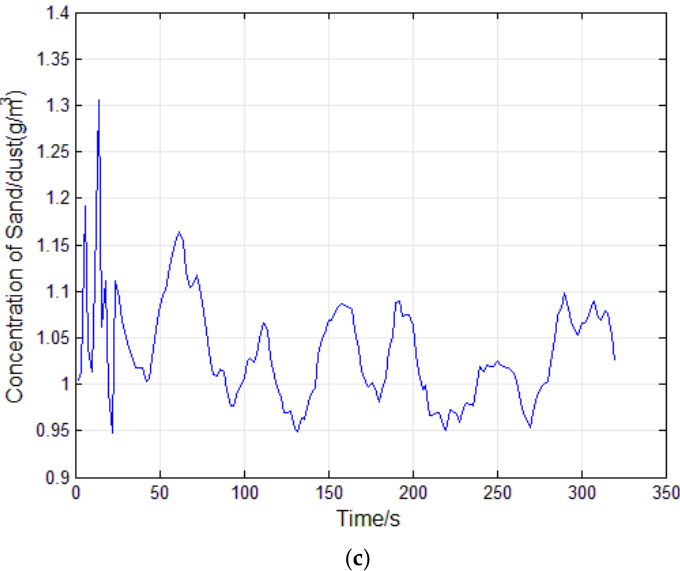
Figure 13. ( a ) Temperature variation of the test section in the medium sand environment; ( b ) wind speed of the test section in the medium sand environment; ( c ) sand concentration of the test section in the medium sand environment. Table 5. Commissioning Results of 18 m/s Wind Speed, High Temperature and Medium Sand.